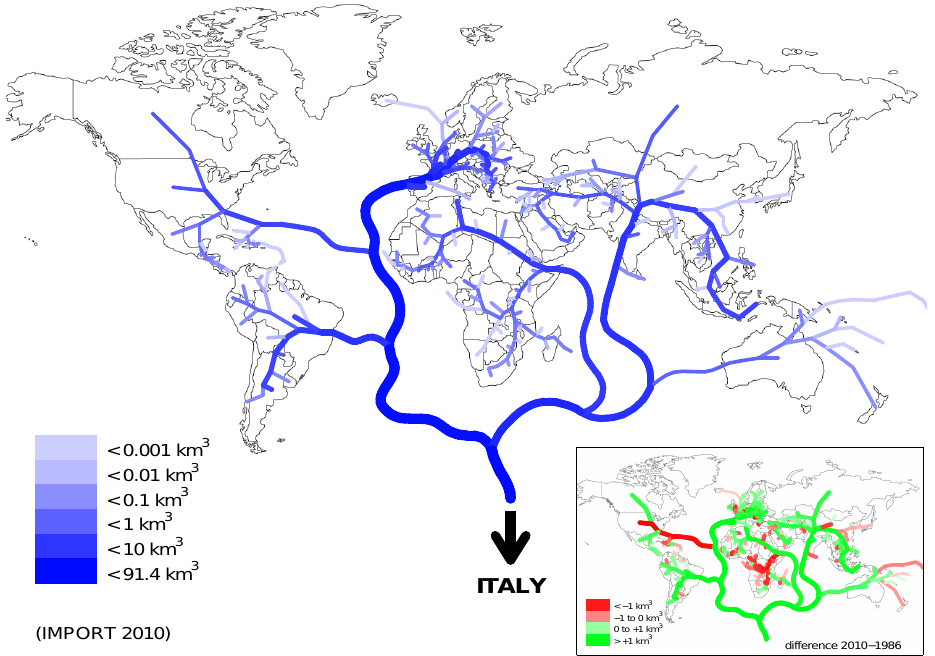
Fig. 1. The virtual water river flowing to Italy in 2010: branches originate in the trading countries and line thicknesses and colors indicate the virtual water volumes imported by Italy. Differences in import fluxes between 2010 and 1986 are reported in the inset.